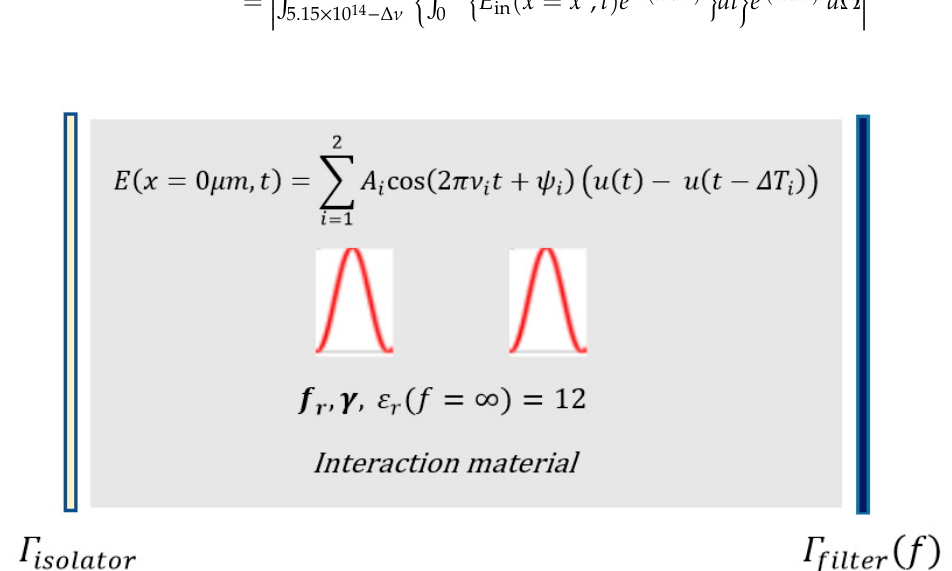
Figure 7. Nonlinear mixing of two ultrashort pulses in an optical microcavity, whose frequencies were tuned for high-intensity targeted harmonic generation at 515THz.